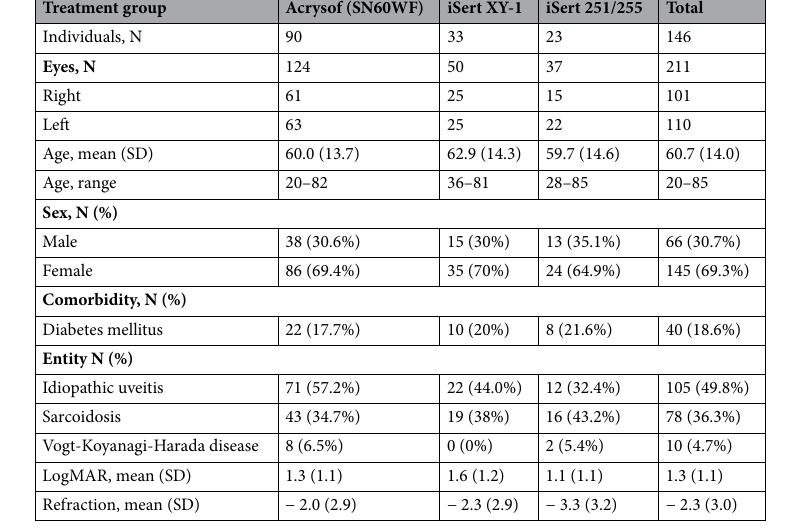
Table 1. Baseline characteristics stratified by treatment group. SD standard deviation, LogMAR log of the minimum angle of resolution.